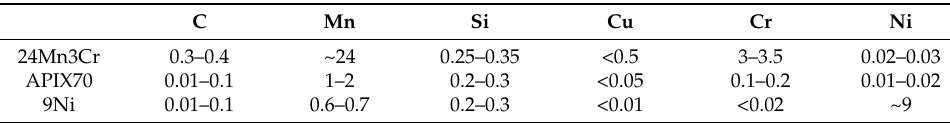
Table 1. Chemical composition of the three tested